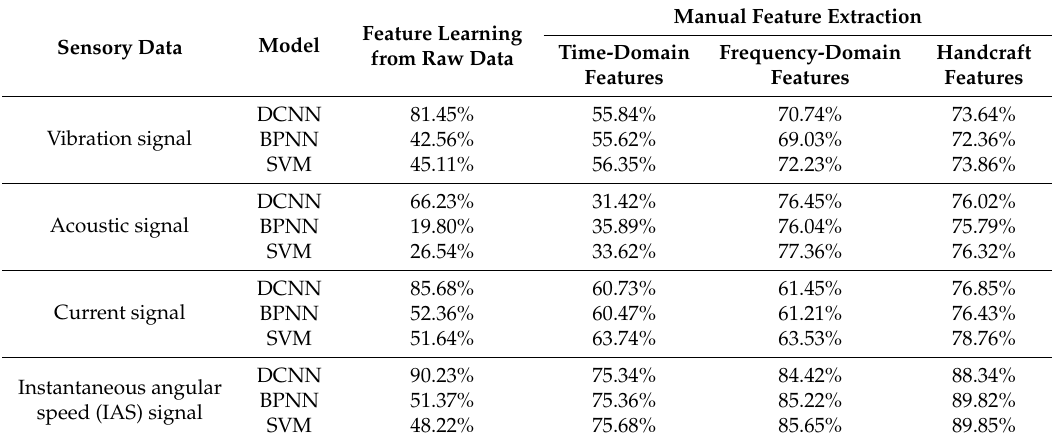
Table 3. Average testing accuracy of comparative methods with single sensory